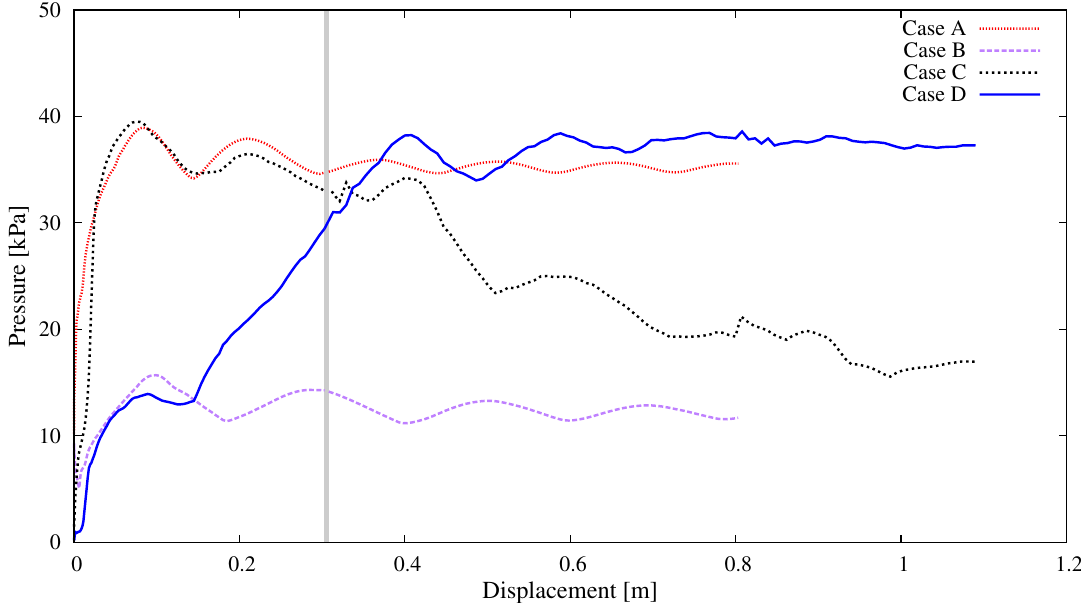
Figure 9. Simulation results of different pipe segments: curves of the thrusting pressure vs. displacement